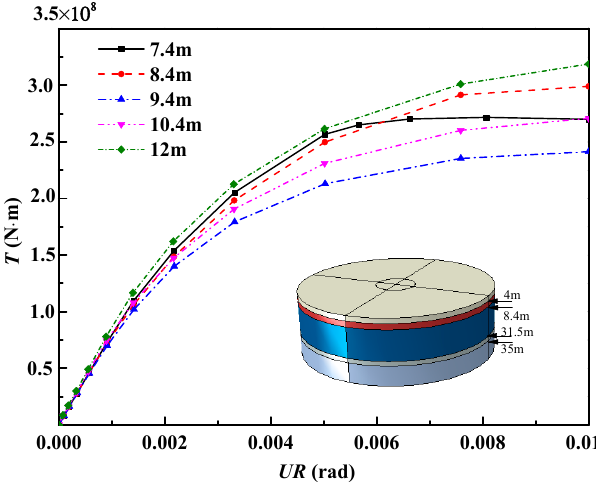
Figure 5. The rotation-torque curves under different bucket skirt heights.